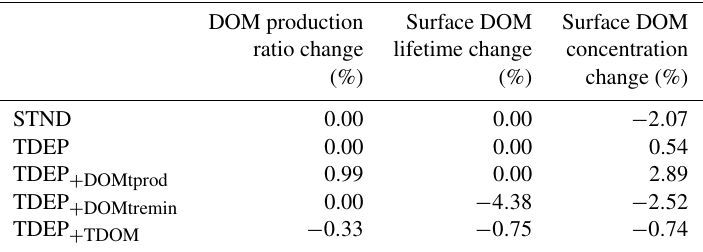
Table 6. Anomaly (%) DOM parameters for 2010 with respect to